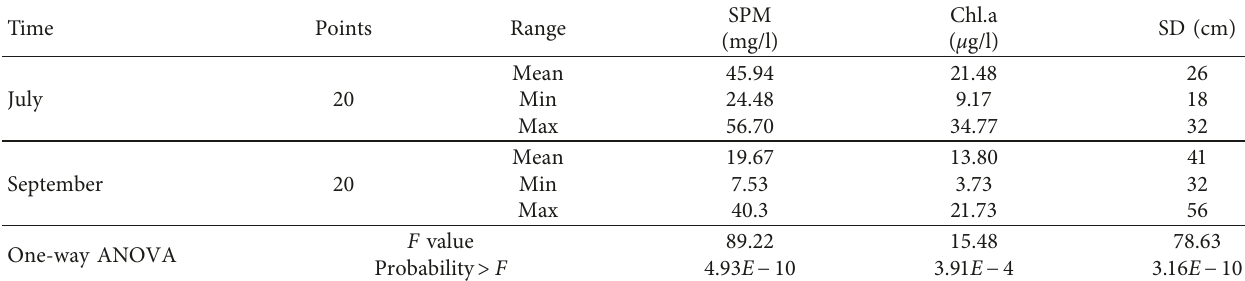
Table 1: Range of concentrations of the main OACs during two periods in